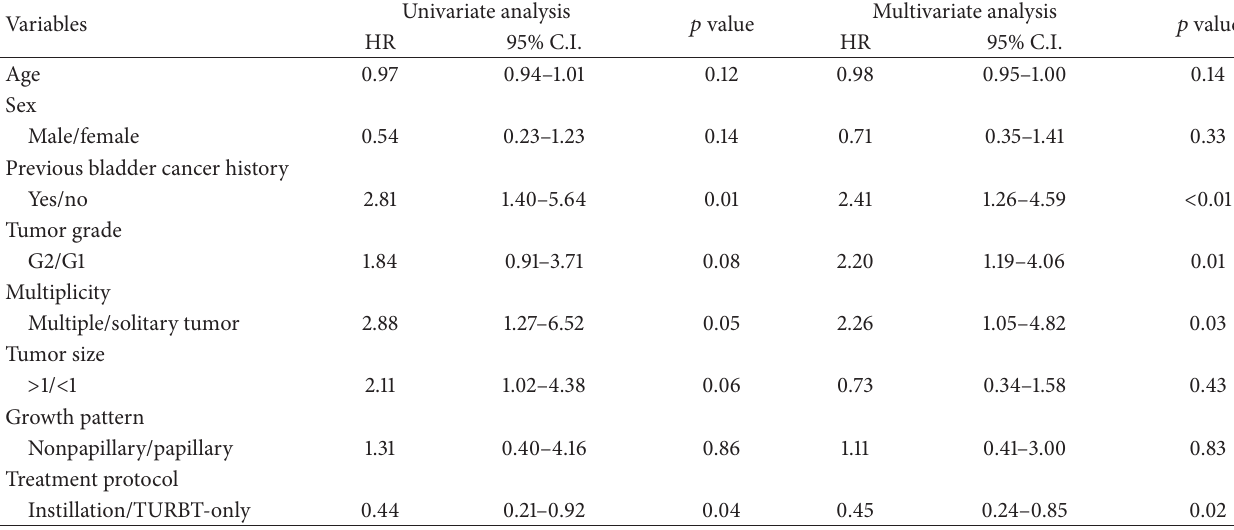
Table 2: Univariate and multivariate analysis of significant predictors of tumor